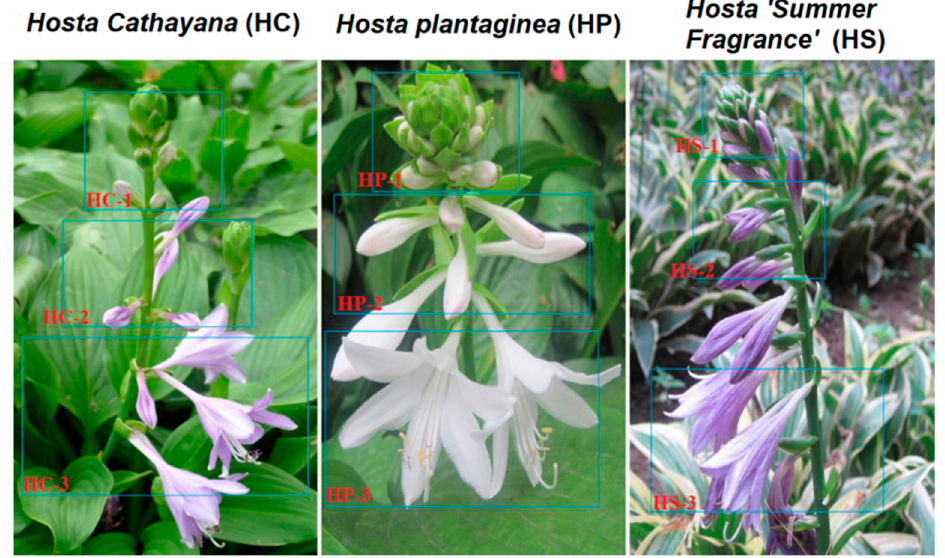
Figure 1. The development and anthocyanin accumulation in Hosta plantaginea (Lam.) Aschers. The blue boxes in the images mark the different flowering stages to compare the colors of the three varieties in the flower bud stage (HC-1, HP-1, and HS-1), the initial flowering stage (HC-2, HP-2, and HS-2), and the late flowering stage (HC-3, HP-3, and HS-3).